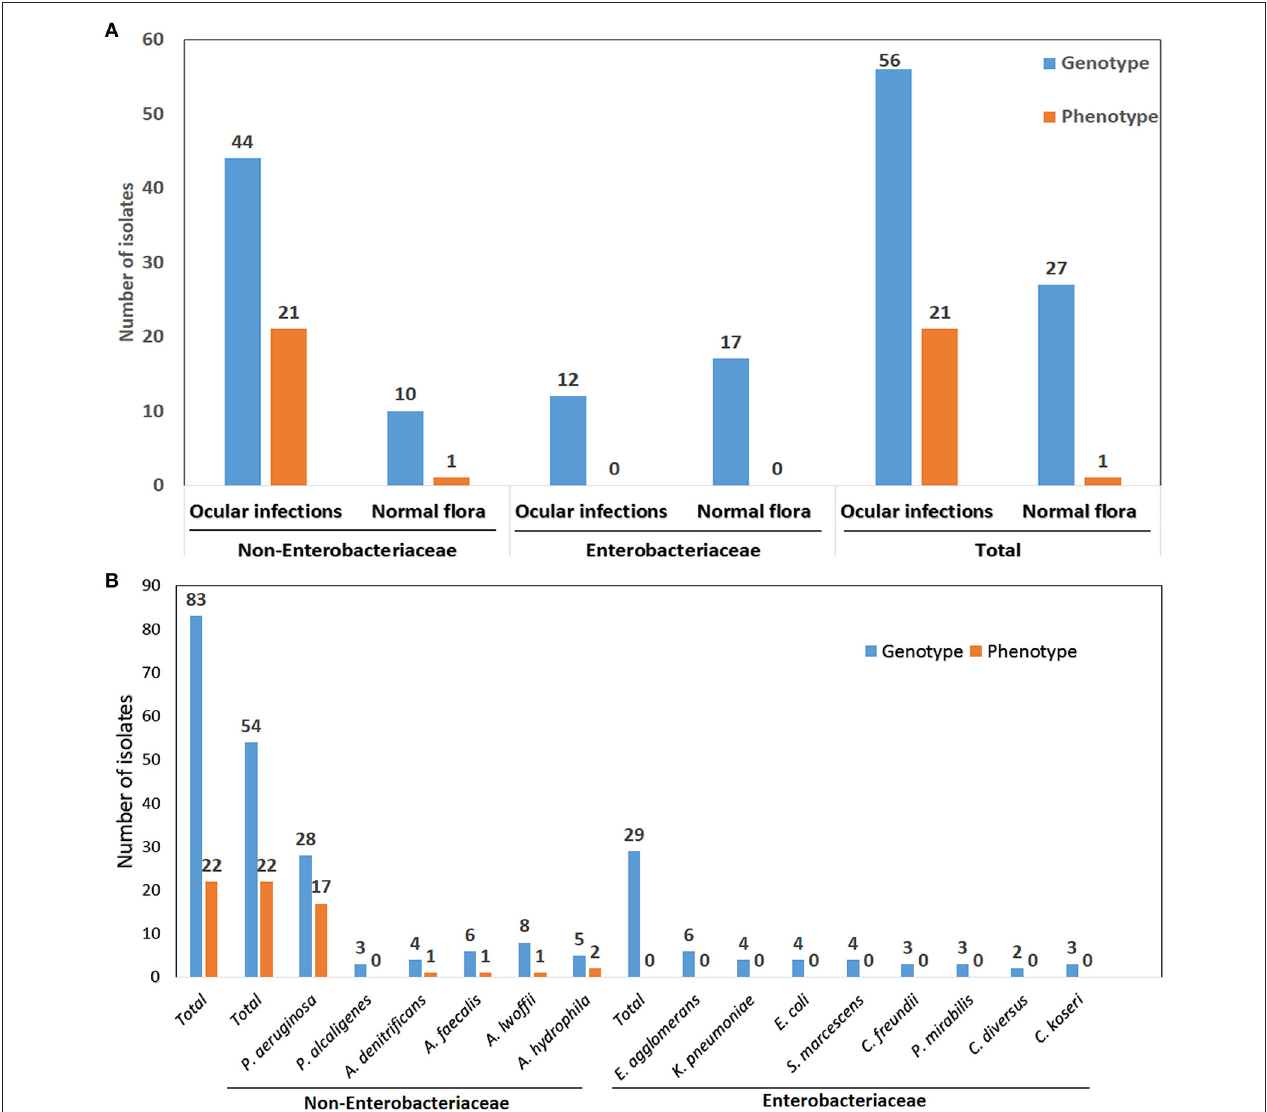
FIGURE 3 | (A) Correlation of genotype and phenotype results of Non- Enterobacteriaceae and Enterobacteriaceae family isolates from various ocular infections and normal flora (B) Organisms wise correlation of genotype and phenotype